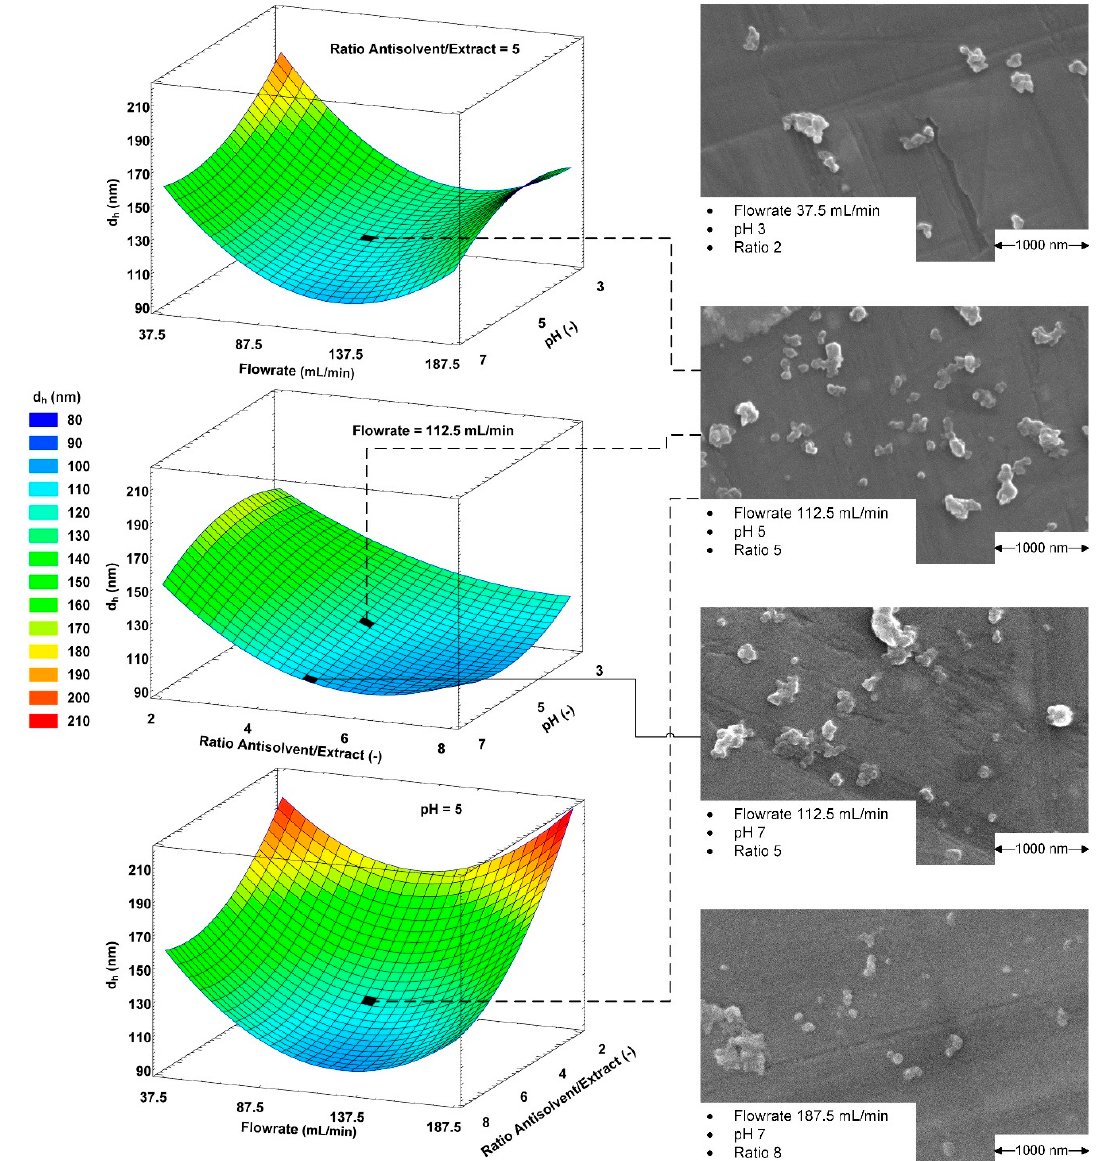
Figure 2. Effect of independent variables’ interaction on the hydrodynamic diameter of the resulting particles and SEM images of selected precipitation parameters.